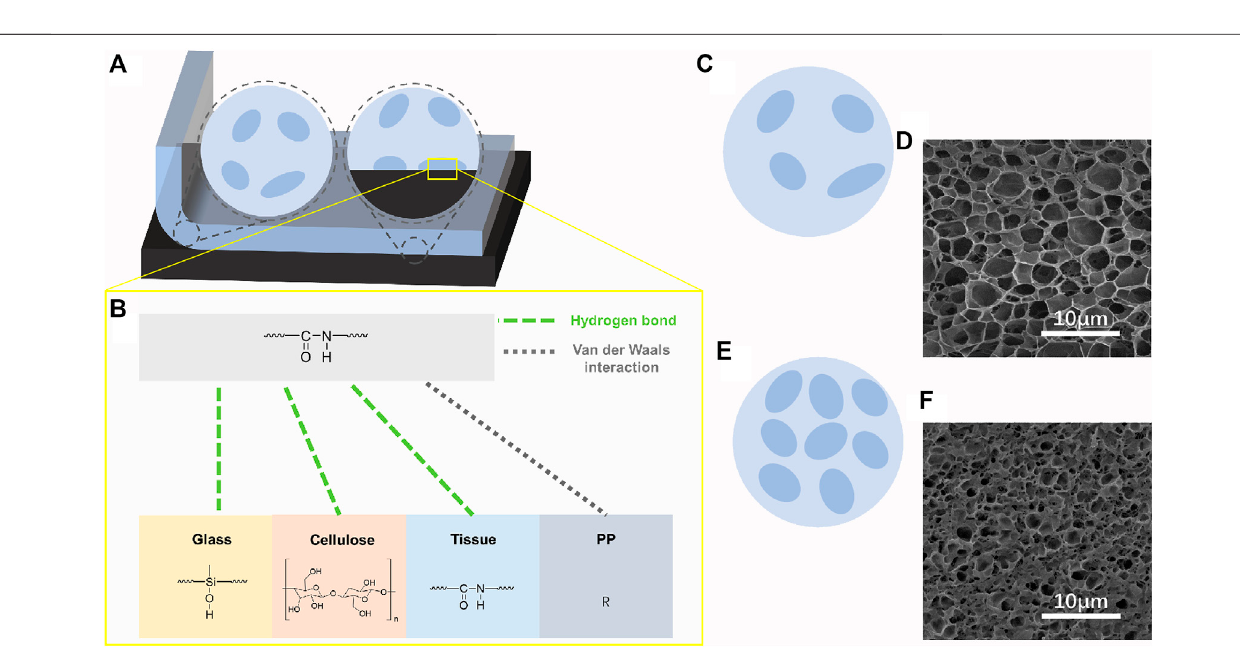
Frontiers in Chemistry |